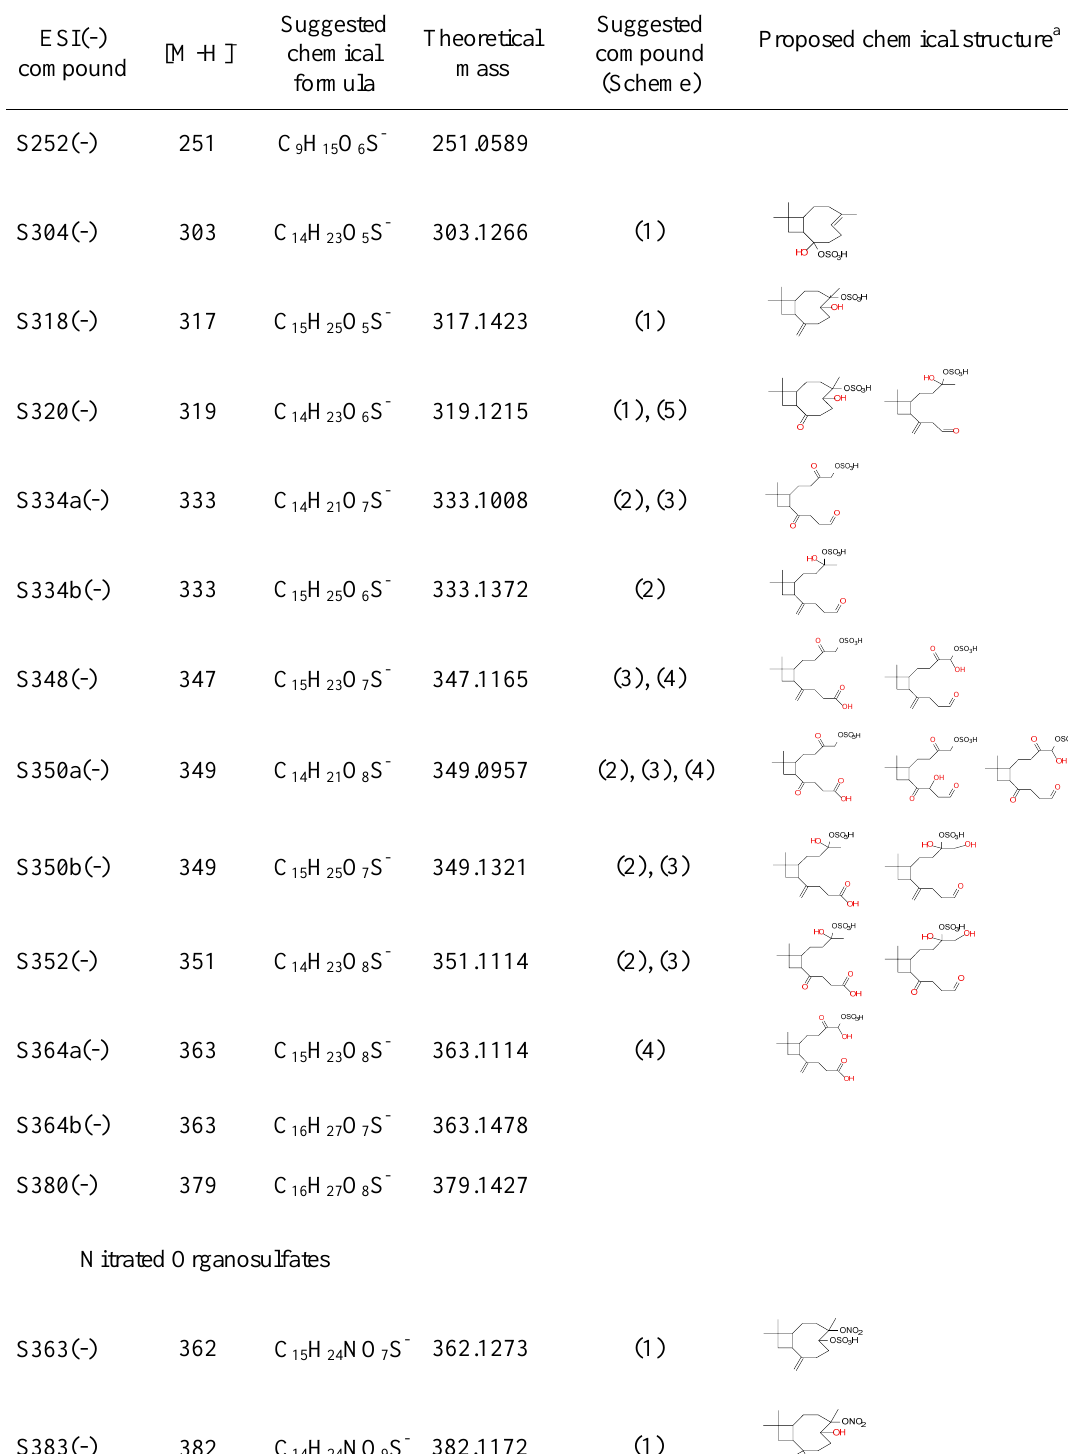
Table 5. Compounds detected by ESI in the negative ion mode in the series of β -caryophyllene/NO x irradiation experiments (Organosul-